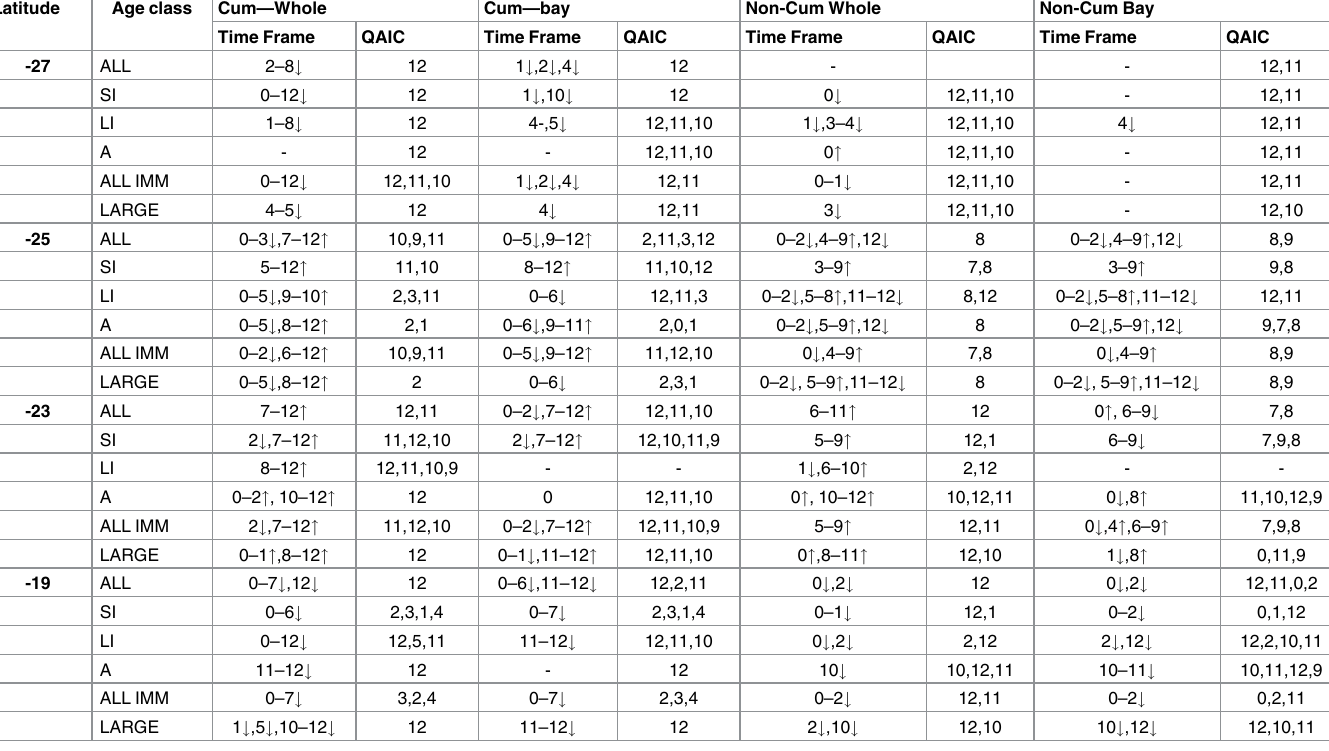
Table 2. Model results for green turtles and rainfall. " denotesincreasedstrandingsrates with increasedrainfall. # denotes decreased stranding rates with increasedrainfall. Age class abbreviations: ALL = all turtles, SI = small immature, LI = large immatures, A = adult-sized, ALL IMM = all immaturesized ani- mals (small + large), Large = all large turtles (large immatures + adult-sized). The time frame is reportedin monthly rangeswhere responses were noted. The values reportedin qAIC are the months with the most significantqAIC